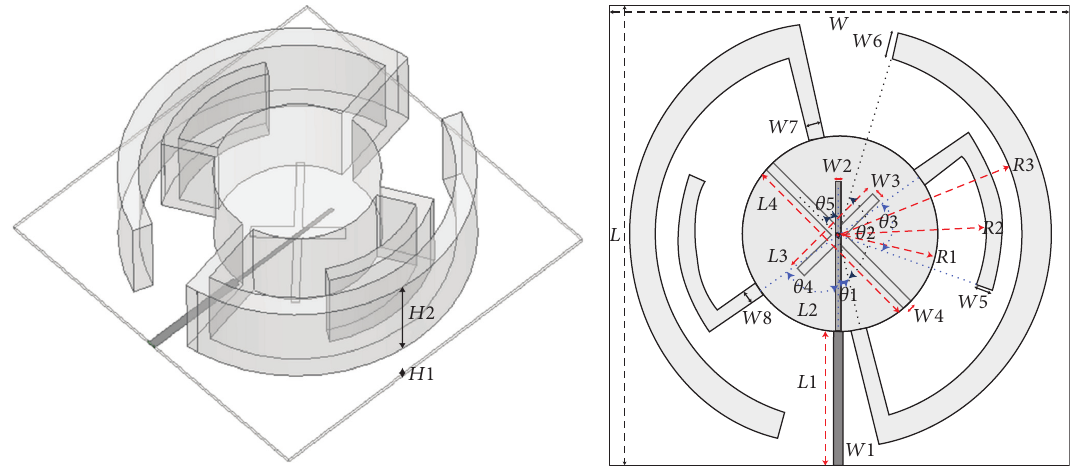
Figure 1: The structure of the presented CP DRA. Table 1: The geometrical